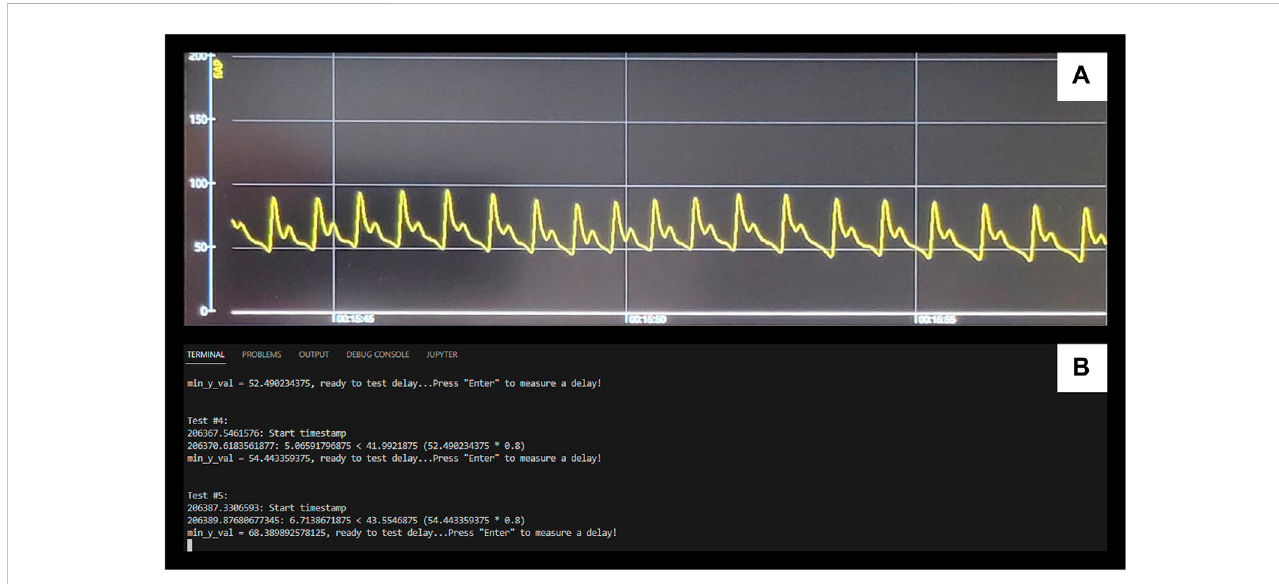
FIGURE 4 Example of Finapres Nova signal outputdelay test (A) , Displaysthe niABP output on the Finapres Nova display. (B) , Displays the output of Python module for retrieving the start and end timestamps. The drops in the signal from (A) correlate to “ enter ” being pressed on (B) to start a test and the end timestamp is automatically outputted when measures of the signal has dropped below a minimum value. NiABP, non-invasive continuous arterial blood pressure.